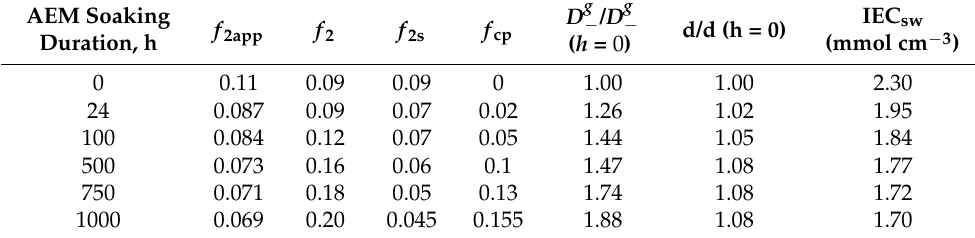
Figure 4. The conductivity of the AEMs soaked in the synthetic polyphenol-containing solution vs. NaCl concentration. Markers show the experimental data measured for sample soaking duration 0 (1), 24 (2), 100 (3), 500 (4), 750 (5) and 1000 (6) hours; dashed lines are the results of calculations according to the modified microheterogeneous model. Adapted from [60]. Table 1. Parameters of the modified microheterogeneous model [60] calculated for the AEM samples soaked with the synthetic polyphenol containing